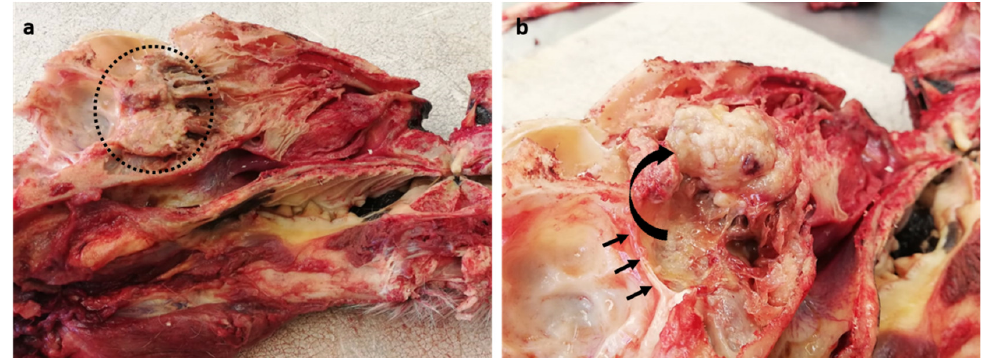
Figure 1. Macroscopic images of the sinonasal meningioma. ( a ) Midline section through skull and nasal cavity revealing an expansile pale neoplastic mass in the caudal nasal cavity (dashed circle). ( b ) Partial dissection and reflection of the mass rostrally (curved arrow) displaying mild compression of the calvarium (three small arrows) by the tumour.